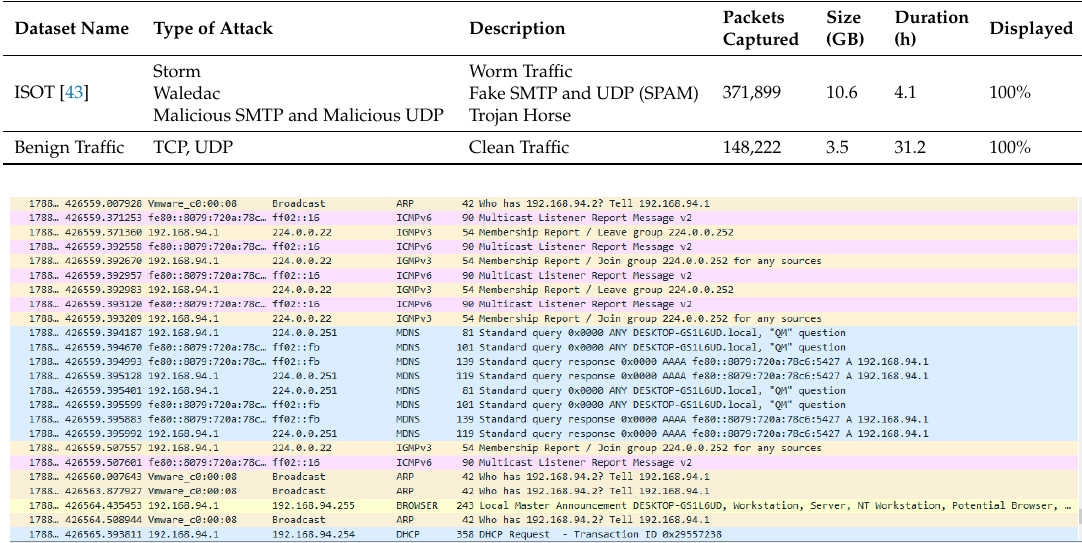
Table 4. Quantitative description of ISOT dataset.